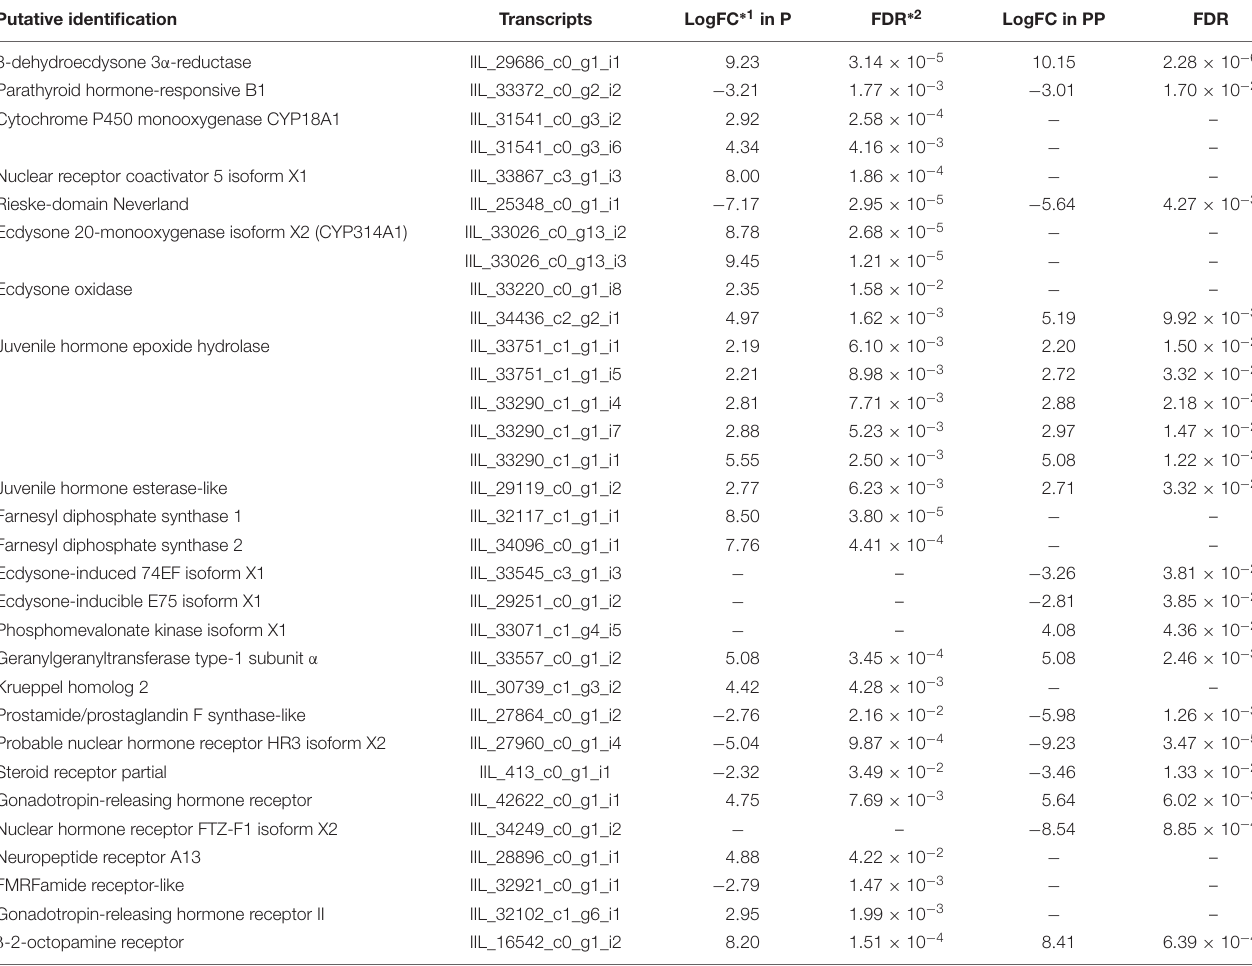
TABLE 1 | Putative identification and fold-change values of transcripts related to the endocrine system of larvae of Diatraea saccharalis parasitized (P) and pseudoparasitized (PP) by Cotesia flavipes. Putative